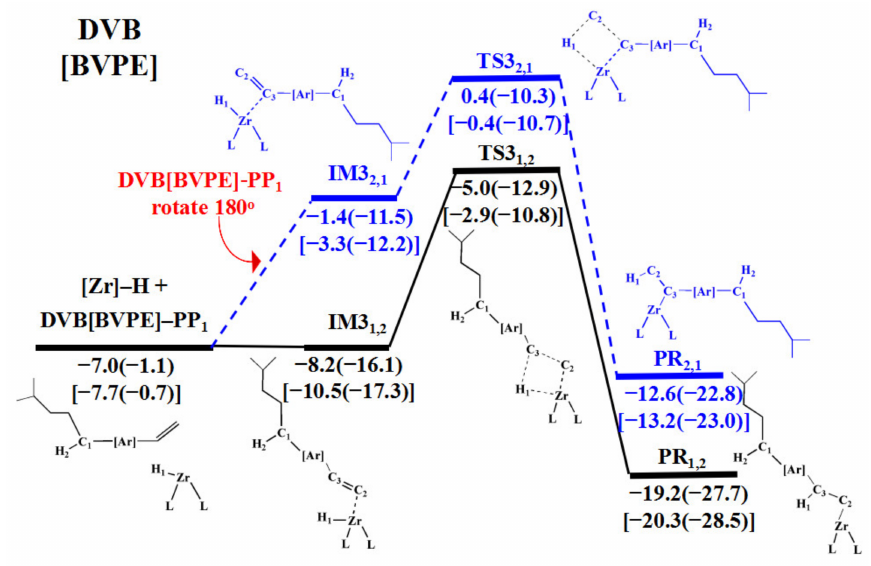
Figure 5. The reaction pathway of the second vinyl bond insertion; the relative free energy is given in kcal/mol, and the relative energy of BVPE is given in brackets; the relative enthalpy is also given in parentheses for reference (in kcal/mol).